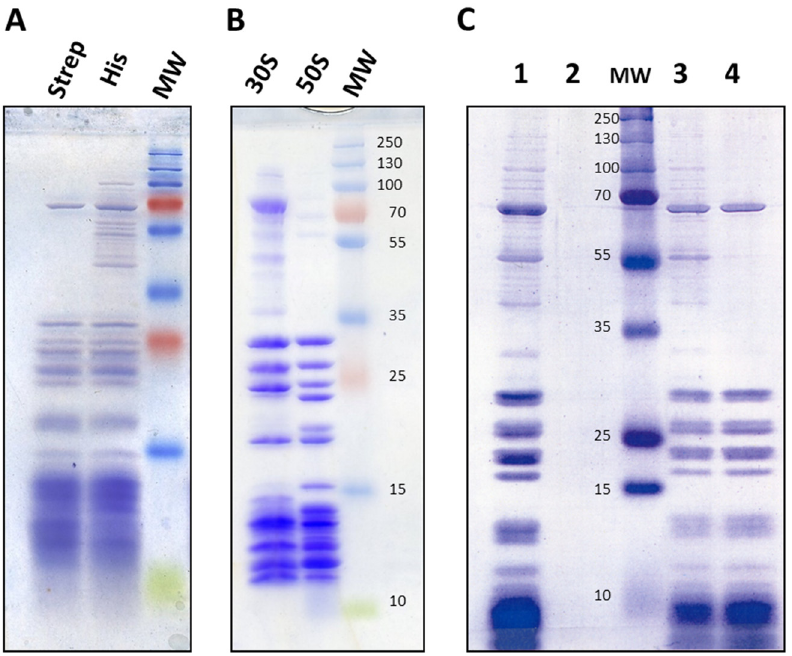
Figure 1. Ribosome purification and subsequent synthesis under heat stress. ( A ) Protein extracts from the Escherichia coli E6006 strain were either loaded onto streptactin columns and eluted with desthiobiotin (for Strep), or loaded onto NiTa resins and eluted with imidazole (for His). MW, molecular weight marker. ( B ) Purified ribosomes were loaded onto a streptactin resin, then flow- through (50S) and elution (30S) were analyzed. ( C ) MG1655 (pE7867) cells were grown overnight at 30 °C in LB medium containing 10 mM glucose, then inoculated in LB medium containing arabinose (lane 1) or glucose (2), and grown at 45 °C to an OD600 of 0.8. The same was done just in arabinose (1 mM), and grown at either 30 °C (3) or 45 °C (4). The ribosomes were loaded onto streptactin columns, and the eluted proteins were analyzed.